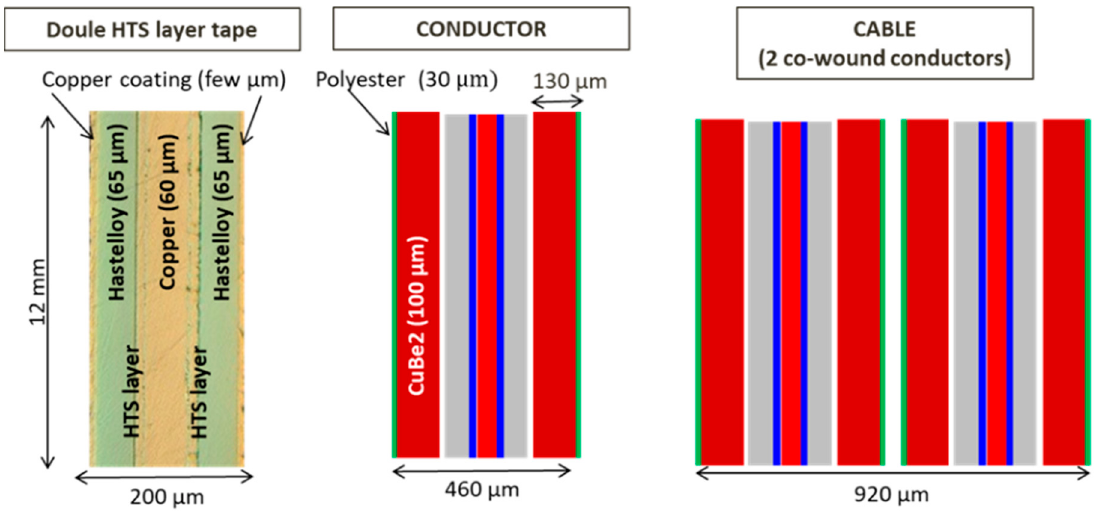
Figure 3. Left: picture of the cross-section of the basic HTS unit (two HTS tapes soldered to a central Cu ribbon); center: scheme of the conductor, with the double tape in between two Cu-Be ribbons with insulation; right: the cable composed of two independent conductors (courtesy of A. Ballarino, CERN and M Durante, CEA).